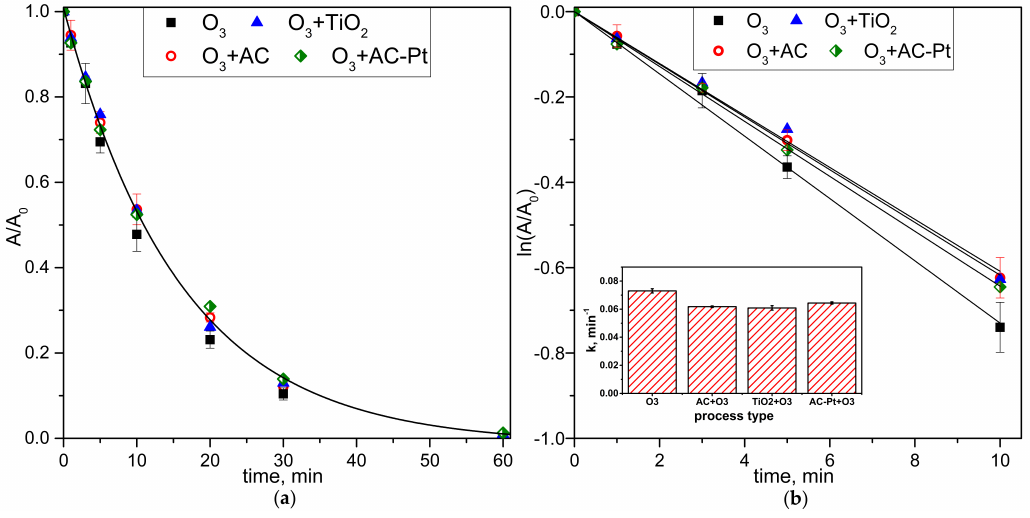
Figure 1. The raw (unpretreated) industrial wastewater during ozonation and catalytic ozonation using three types of catalysts ( a ) and pseudo-first-order rate of color removal ( b ).